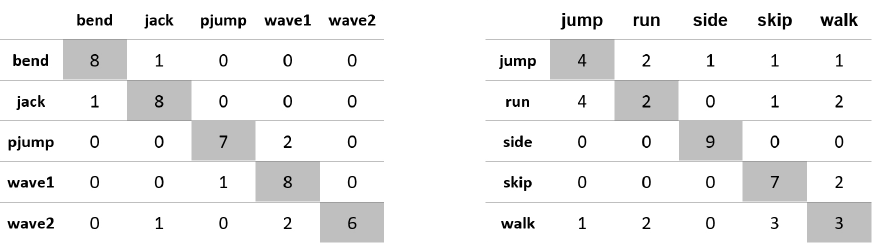
Figure A4. Confusion matrices for the experiment using the ‘lower-occlusion’ database, MBR width and Euclidean